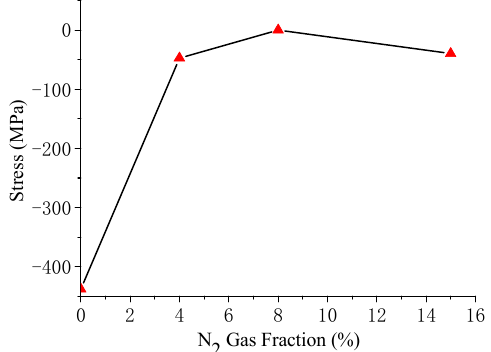
Figure 4. The stresses as a function of N 2 Gas Fraction for Ni/C multilayers deposited with pure Ar and a nitrogen-argon gas mixture.